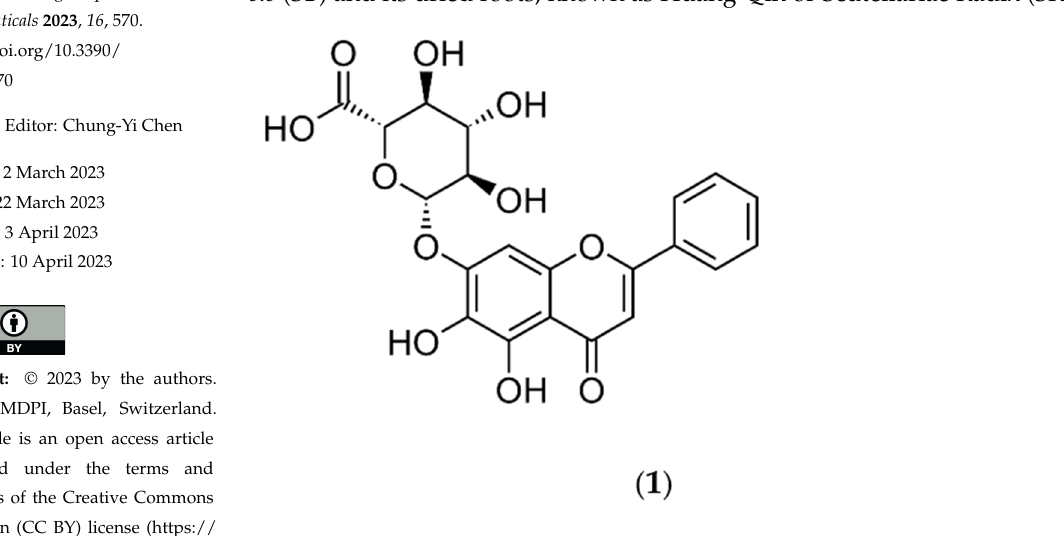
Figure 1. The chemical structure of baicalin ( 1 ).